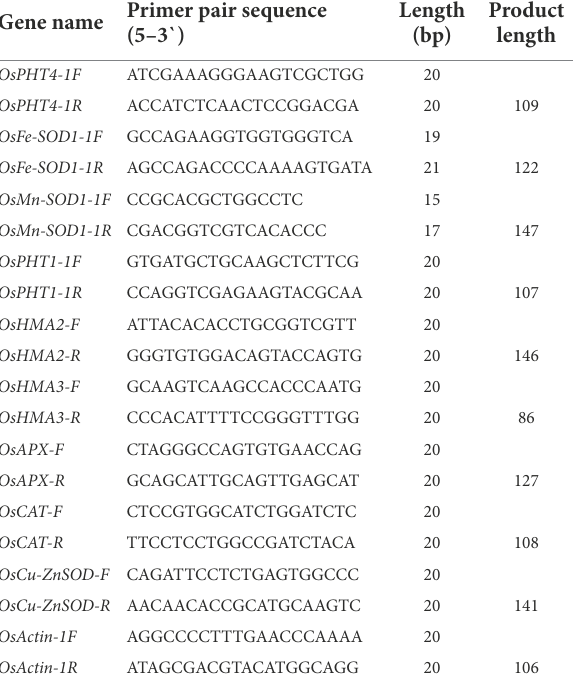
TABLE 1 List of Oryza sativa specific primer sequences used in this study. Primer pair sequence Gene name